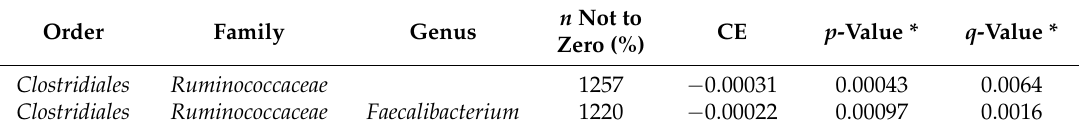
Table 4. The correlation between identified taxa and platelet count on MaAsLin analysis. n Not Order Family Genus